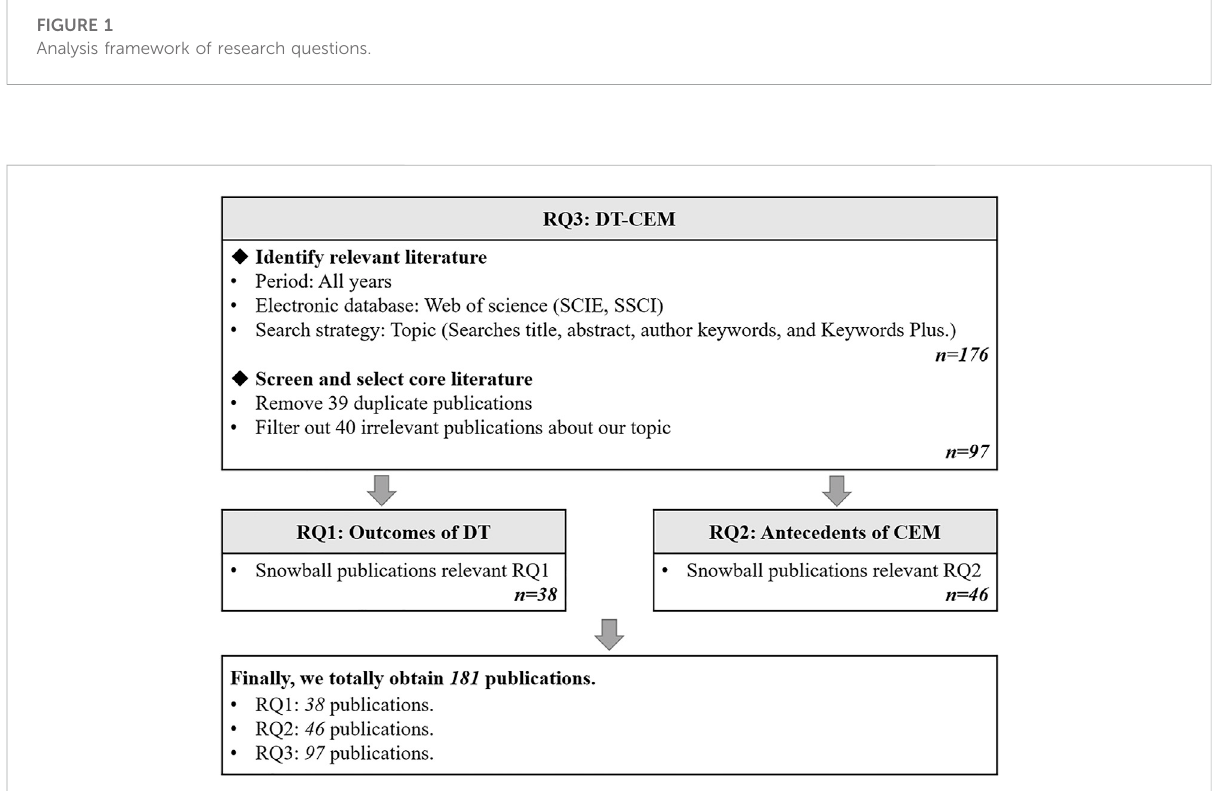
FIGURE 2 Systematic review